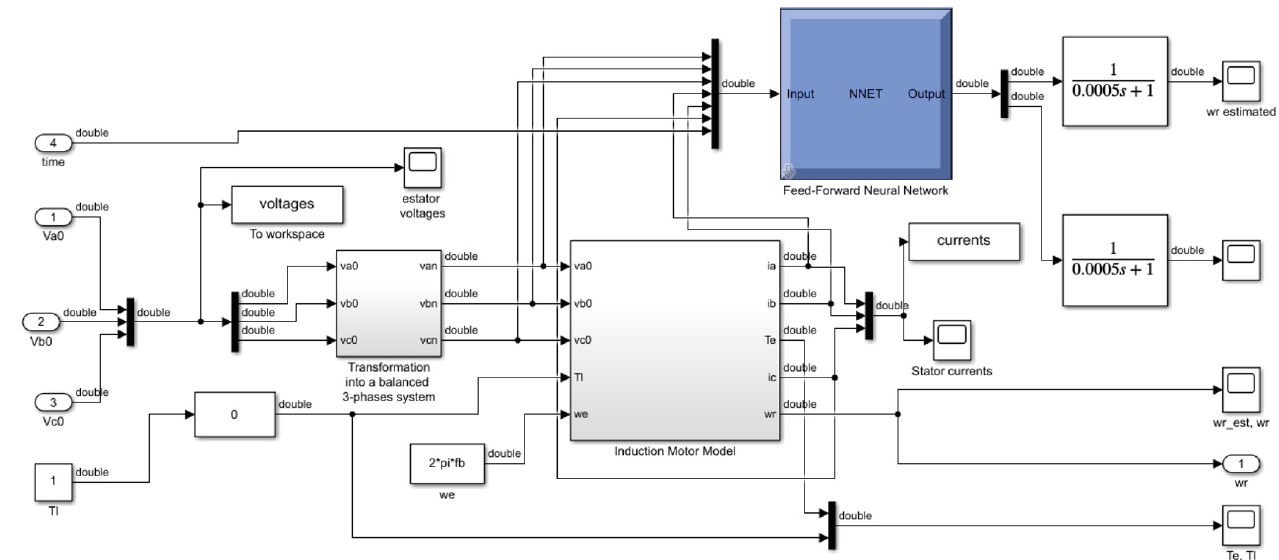
Figure 13. The construction of the ff ANN block in Simulink. Detailed implementation of the IM drive Simulink model, including the generated block.